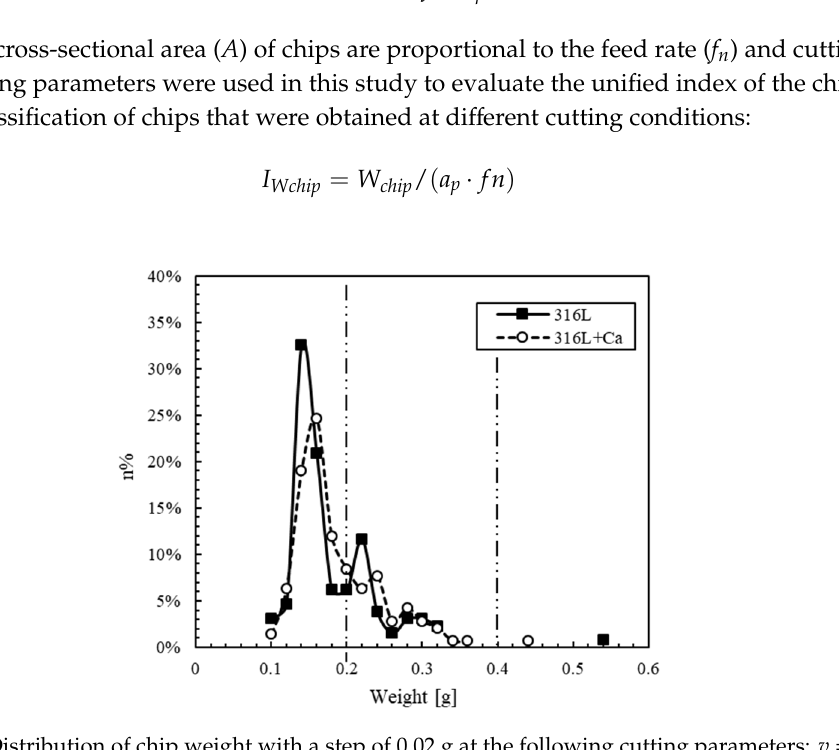
Figure 3. Distribution of chip weight with a step of 0.02 g at the following cutting parameters: v = 130 m/min, a p = 3 mm, f n = 0.5 mm/rev.